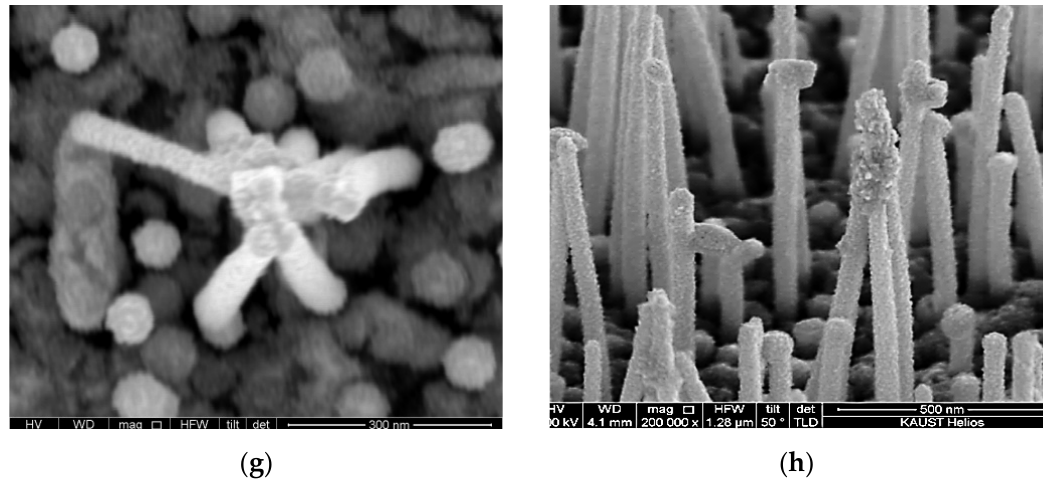
Figure 5. SEM images of ZnO NWs grown by PLD Top ( a , c , e , g ) and tilted ( b , d , f , h ) view; ( a , b ) before PbS deposition, and ( c – h ) after PbS deposition for different cycles: ( c , d ) after 5 SILAR cycles, ( e , f ) after 10 SILAR cycles and ( g , h ) after 16 SILAR cycles.